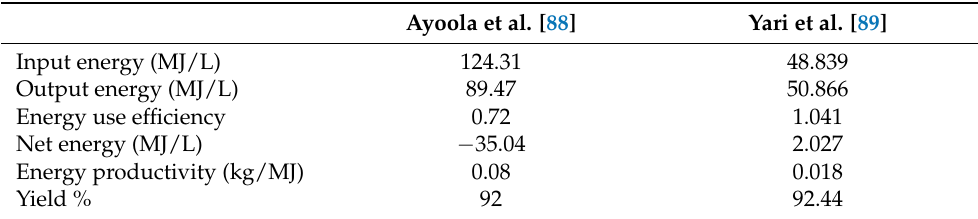
Table 3. Comparison between the input and output energies and the energy